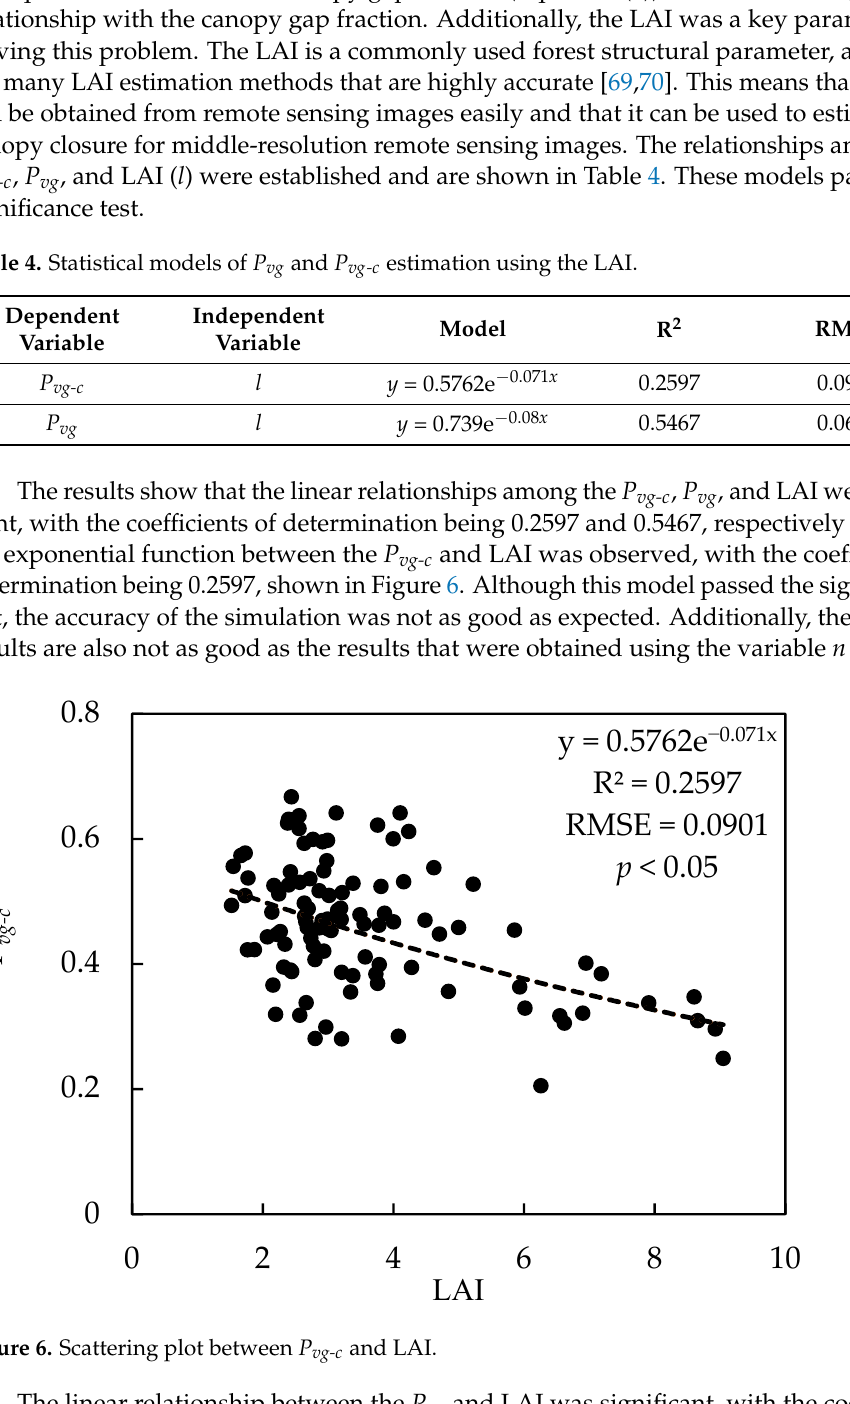
Table 4. Statistical models of P vg and P vg-c estimation using the LAI.